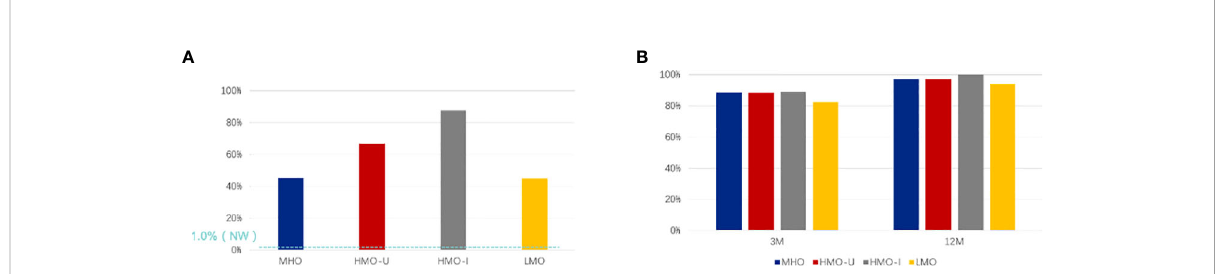
FIGURE 3 Comparison of different AIM subgroups of obesity for the rate of hyperinsulinemia pre-surgery (A) and remission rate post-surgery (B) . (A) The rate of hyperinsulinemia pre-surgery; (B) Remission rate of hyperinsulinemia at 3-month (3M) and 12-month (12M) post-surgery. MHO,